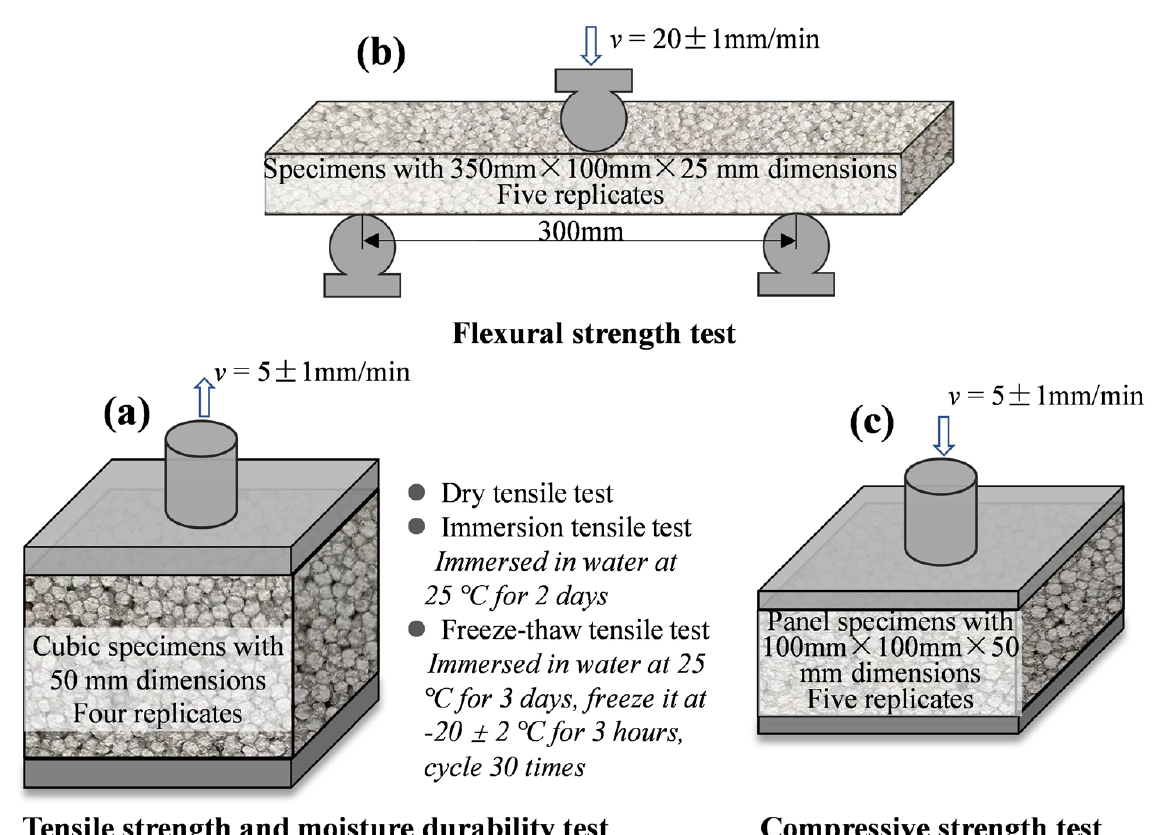
Figure 2. The mechanical property and durability tests: ( a ) flexural strength test, ( b ) tensile strength and moisture durability test, and ( c ) compressive strength test.